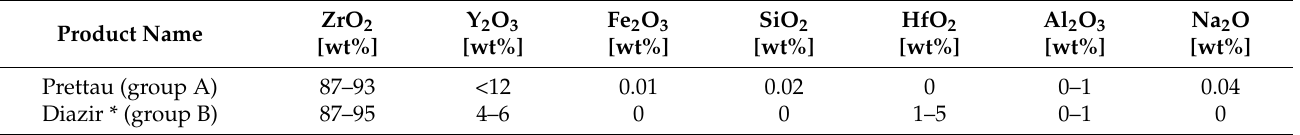
Table 1. Composition in wt% of the